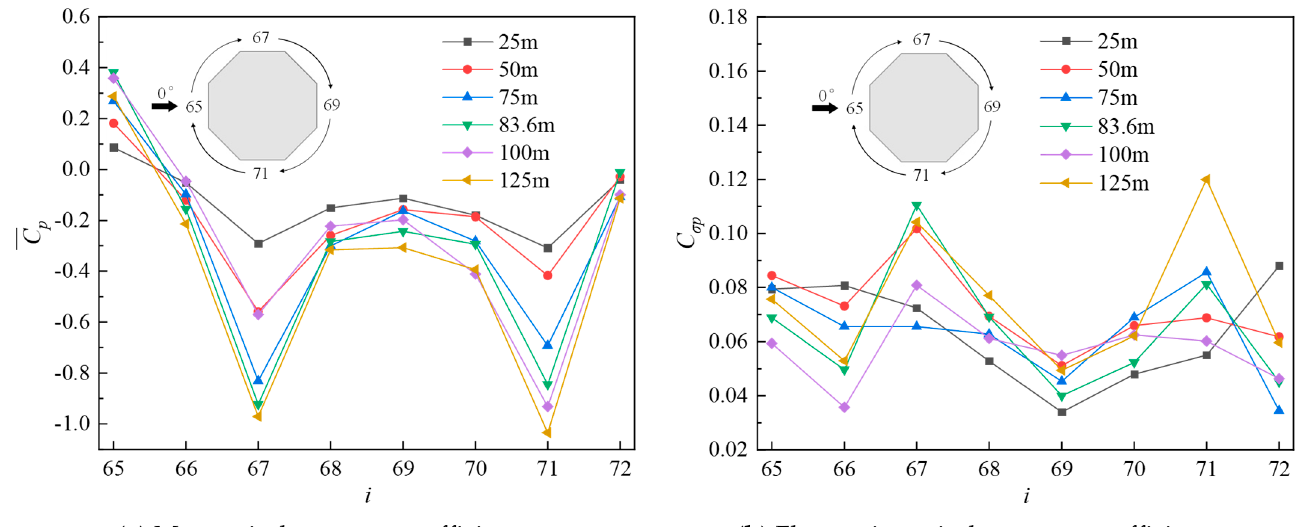
Figure 27. Wind pressure coefficients at each measuring point on the outer surface of the grid struc- ture at a 0° wind direction angle.